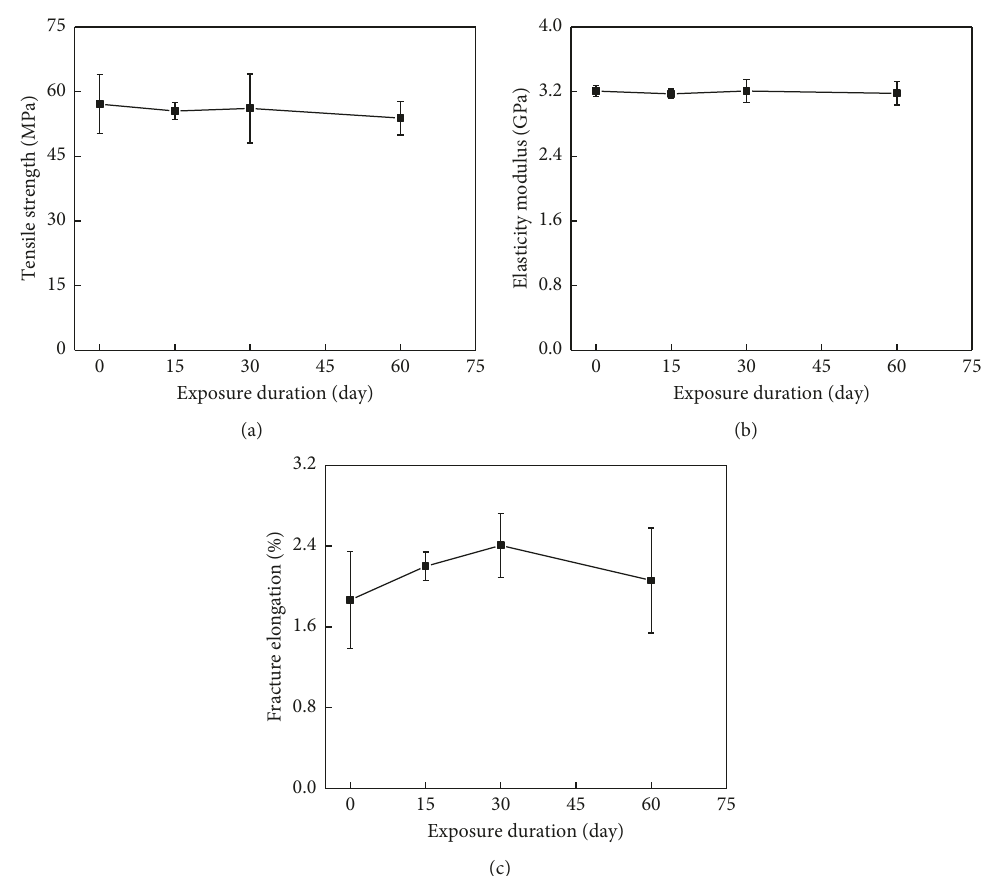
Figure 5: Effects of immersion duration on the tensile strength (a), elastic modulus (b), and fracture elongation (c) of the adhesive.